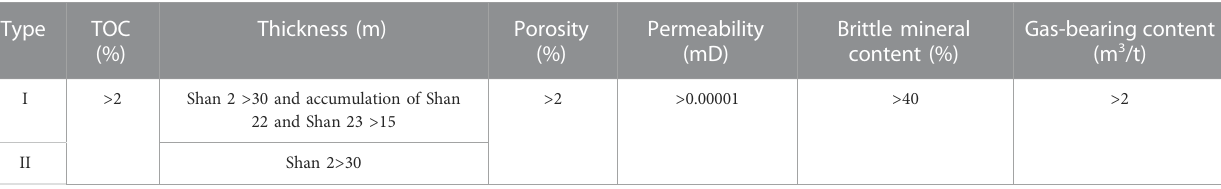
TABLE 2 Evaluation parameter table of the favorable zone of shale gas in eastern Ordos.